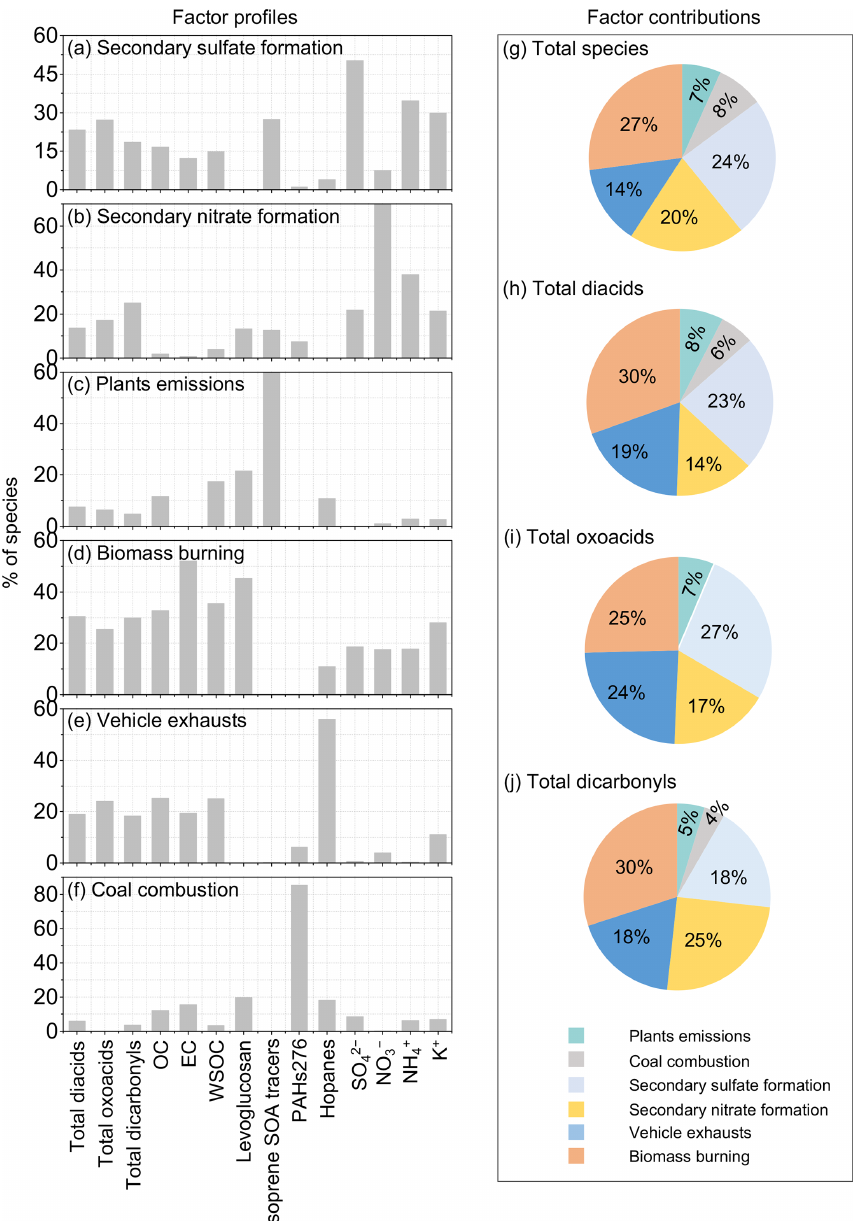
Figure 10. (a–f) Factor profiles (percentage of each species in factor) using ions and organics data for the six factors: (g–j) factor contributions to total species, diacids, oxoacids and α -dicarbonyls.